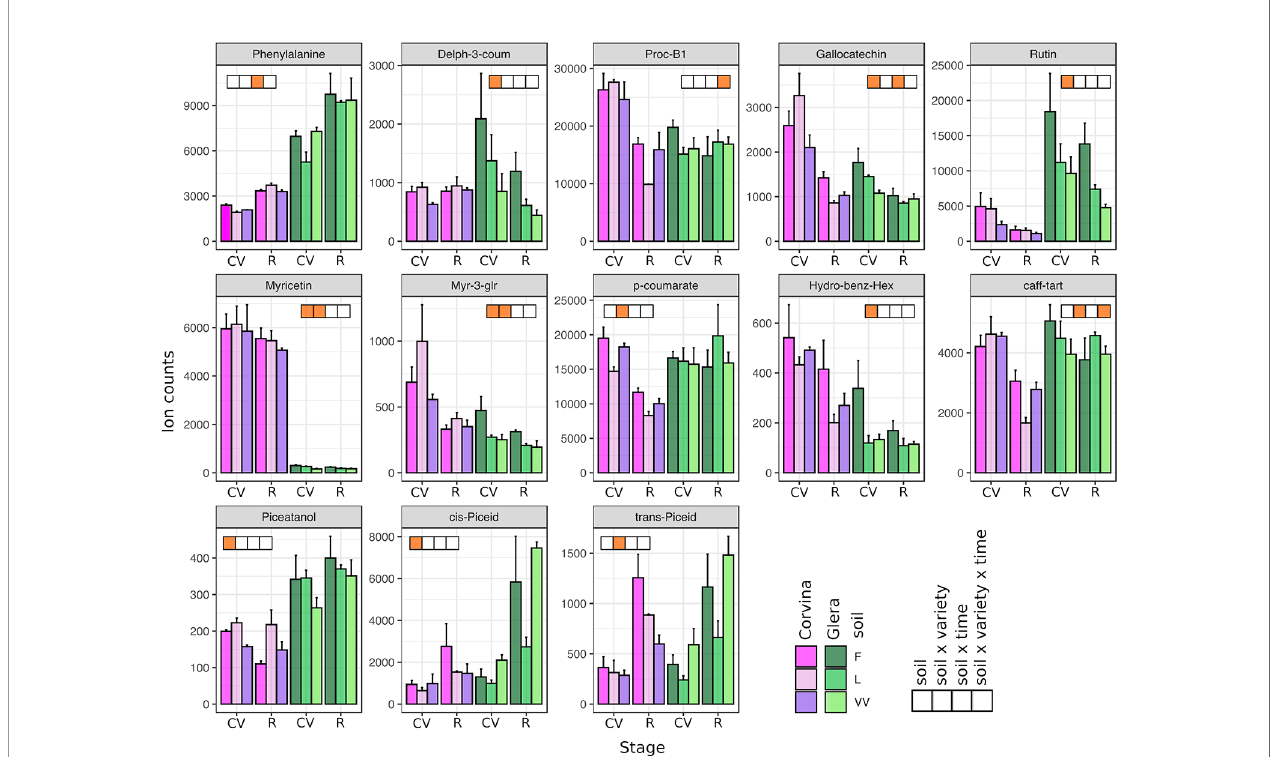
FIGURE 3 | Secondary metabolites detected by LC-MS in berry skin tissues in response to different soils. Included are metabolites found to be signi fi cantly affected by the soil factor and its interactions with other factors (variety and phenological stage) based on multifactorial ANOVA. Levels represent relative abundance based on ion counts. Purple bars represent the Corvina variety and green bars represent the Glera variety. Different color intensities indicate different soils, whereas orange squares indicate the statistical signi fi cance related to soil factor and/or its interactions with the other factors. CV and R stand for complete ve ́ raison and ripening, respectively. Error bars indicate standard error (n =